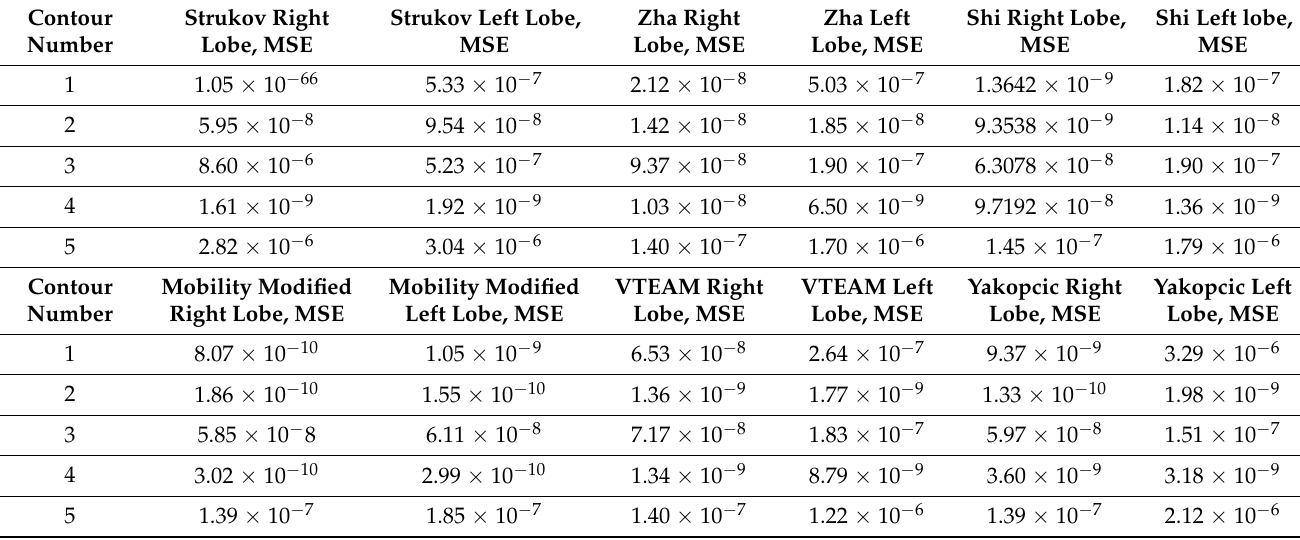
Figure 8. Results of the optimization of the right lobe of the synthetic sampling circuits (Figure 3) by the mobility modification model (MMM). Table 1. Square of the current value difference (MSE) values of optimization task